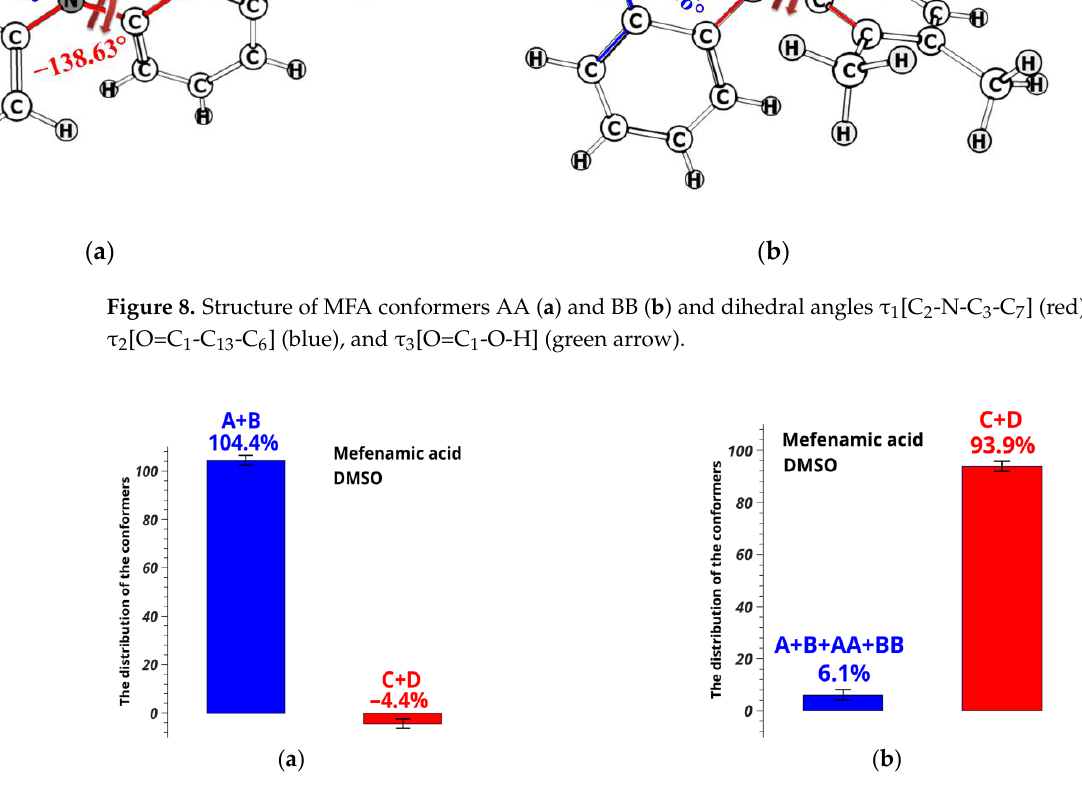
( b ) Figure 10. Distribution of conformers of MFA in scCO 2 + DMSO-d 6 at 9 MPa calculated from the observed conformation-dependent distance OH-H6 ( a ) without and ( b ) allowing for the existence of additional conformers AA and BB. Comparison of the results shown in Figure 10 leads us to a conclusion that the error in determining the conformer fractions in the case of the mixed solvent is also very large, exceeding 50%. Thus, using the model of two-position chemical exchange given by Equation (6) and allowing for the additional conformers, we plotted the dependences of